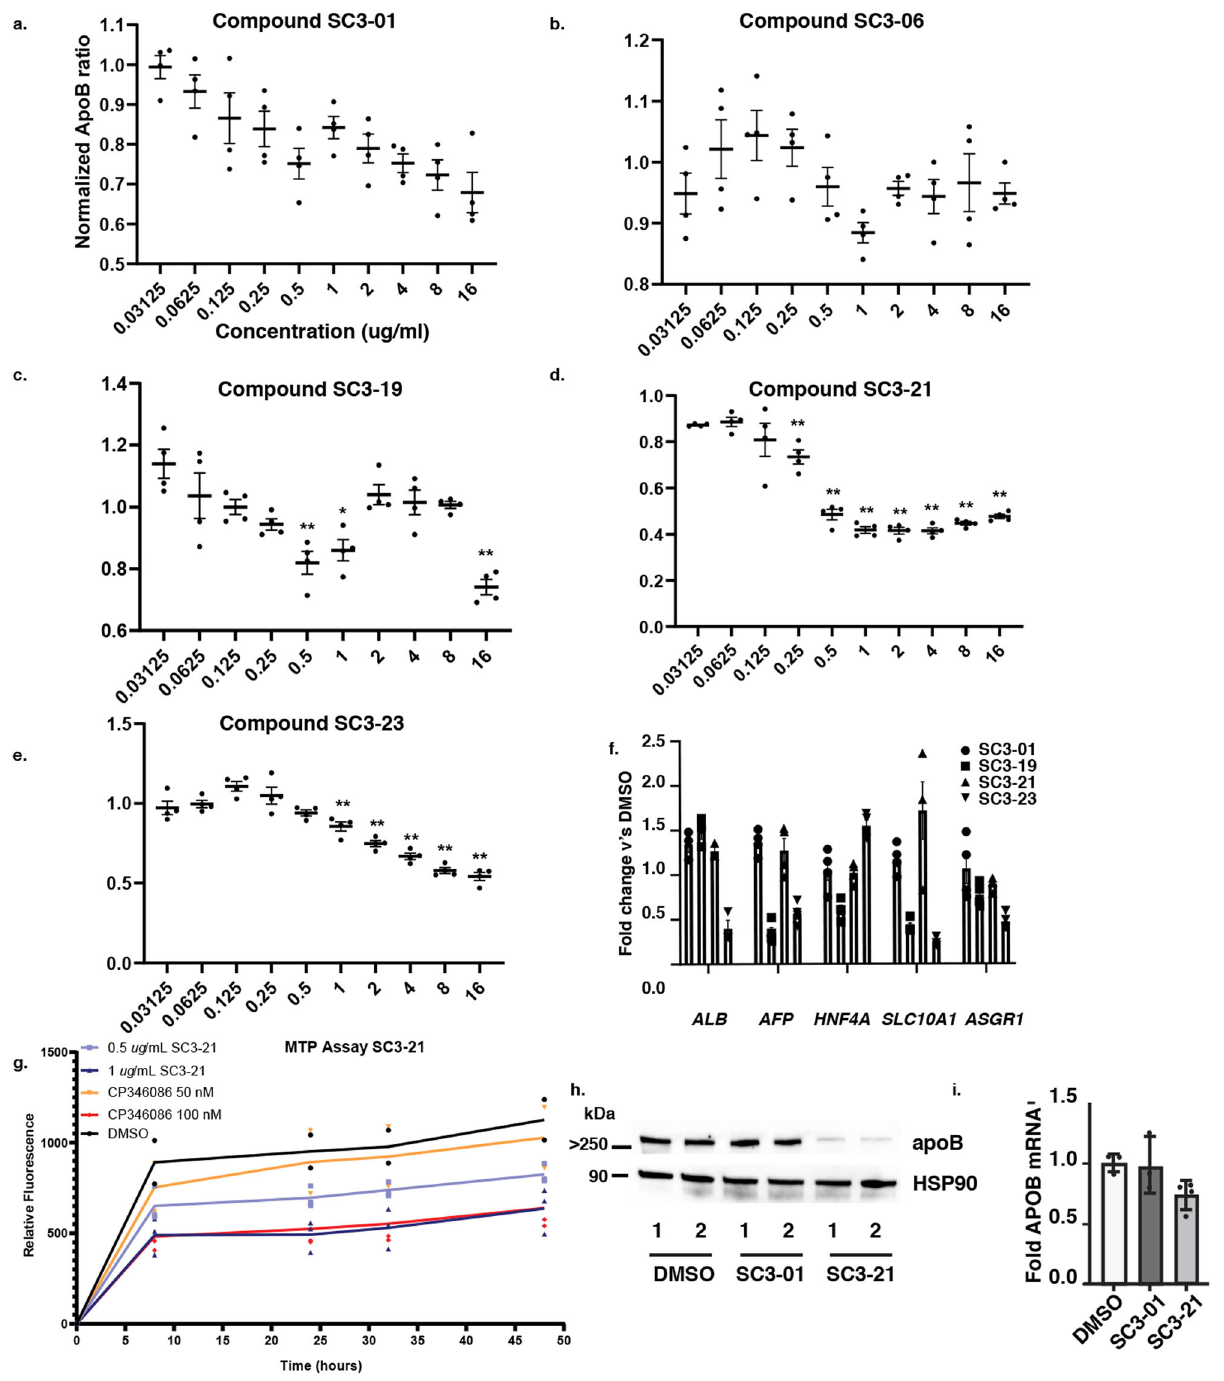
Fig. 3 Characterization of compounds identi fi ed in primary screen. a – e Human iPSC-hepatocytes were treated with compounds SC3-01, -06, -19, -21, and -23 from 0.03125 to 16 µ g/ml for 24 h. Culture medium from pre-drug and post-drug treatment were collected for human-speci fi c apoB ELISA. Post-drug apoB: pre-drug apoB ratio from each treatment was determined and compared to DMSO-treated cells. All data are shown as mean ± SD of three replicates ( n = 3). f Human iPSC-hepatocytes were treated with 2 µ g/ml of compound SC3-01, -19, -21, and -23 for 24 h. Bar graph shows ALB , AFP , HNF4 α , SLC10A1 , and ASGR1 mRNA levels that were determined by real-time qPCR. Fold change was calculated and normalized with vehicle only ( n = 3). Data are shown as mean ± SD. All statistical analysis was performed using Student ’ s t test or one-way ANOVA followed by Dunnett ’ s test as appropriate; * p ≤ 0.05, ** p ≤ 0.01. g Graph showing the impact on in vitro MTP activity of DL-21 (0.5 and 1.0 µ g/ml) and the known MTP inhibitor CP346086 (50 and 100 nM) compared to vehicle (DMSO). h Immunoblots showing the steady-state level of apoB protein in human iPSC-hepatocytes treated with vehicle (DMSO) or 2 µ g/ml SC3-01 or the MTP inhibitor SC3-21. HSP90 levels were used as a loading control. i Human iPSC-hepatocytes were treated with 2 µ g/ml of SC3- 01, SC3-21, or vehicle (DMSO) for 24 h. Bar graph shows normalized steady-state APOB mRNA levels determined by real-time qPCR ( n = 4).